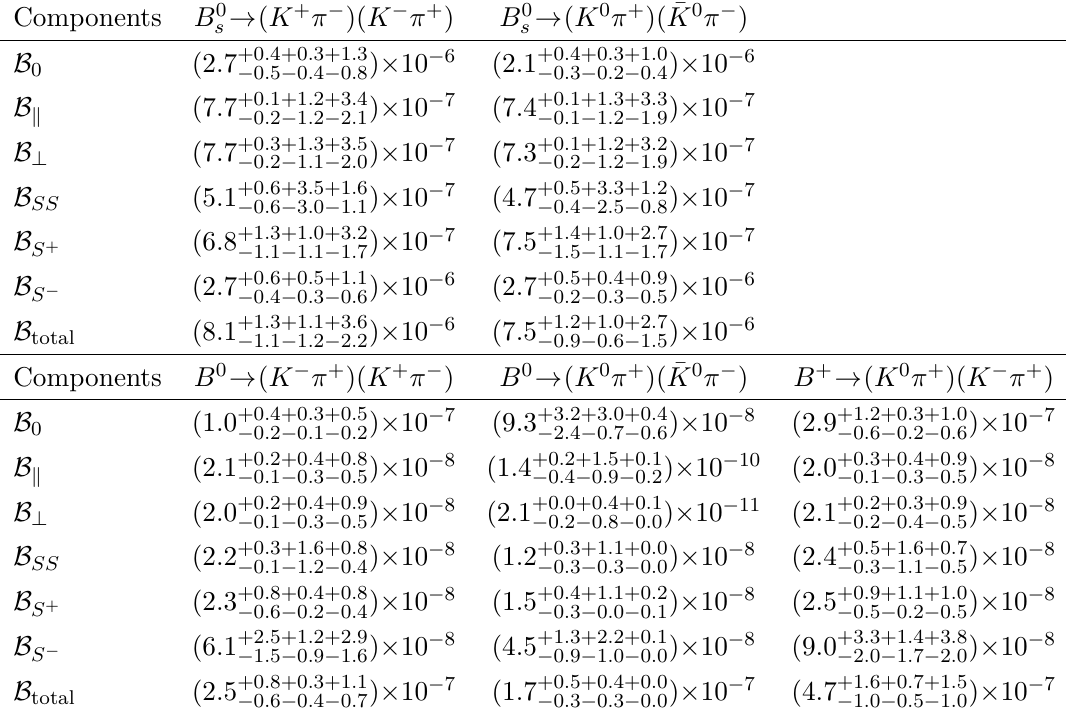
Table 1 . PQCD predictions for the CP -averaged branching ratios of various components and their sum in the B → ( Kπ ) ( Kπ ) decays within the Kπ invariant mass window of 150 MeV ( s ) S/P S/P around the K ∗ (892) resonance.